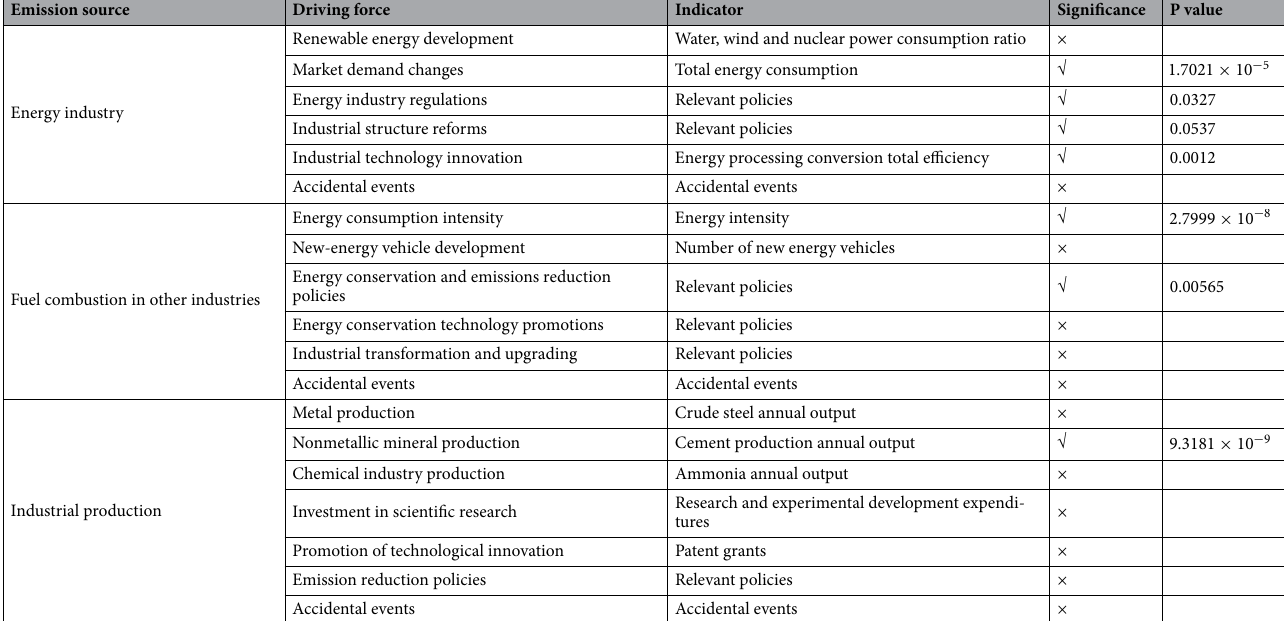
Table 1. Selection of the driving forces.